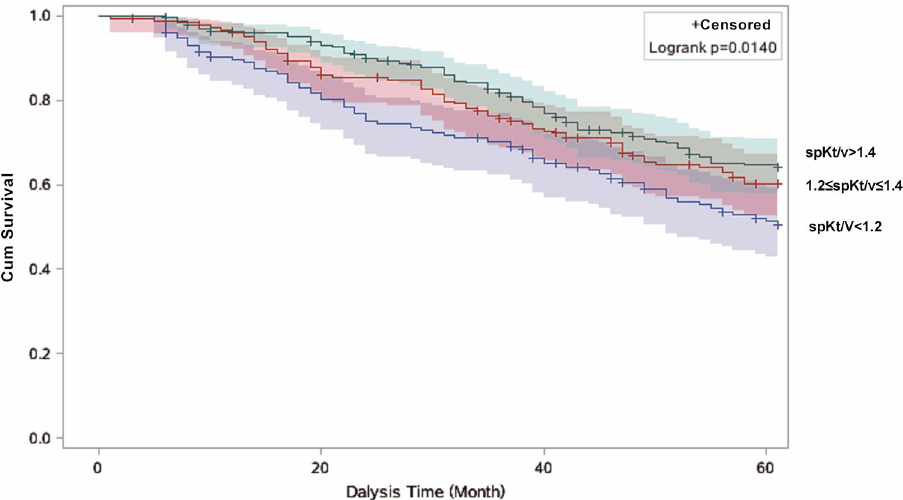
Figure 1. Kaplan–Meier survival estimates of all-cause mortality between the three the dose of hemodialysis subgroups divided by the optimal cutoff value.